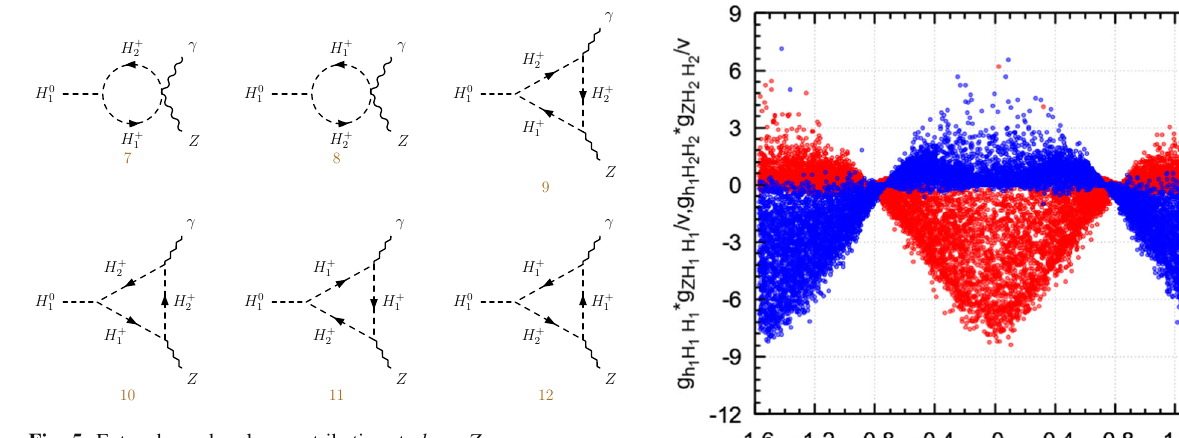
Fig. 5 Extra charged scalars contributions to h → Z γ